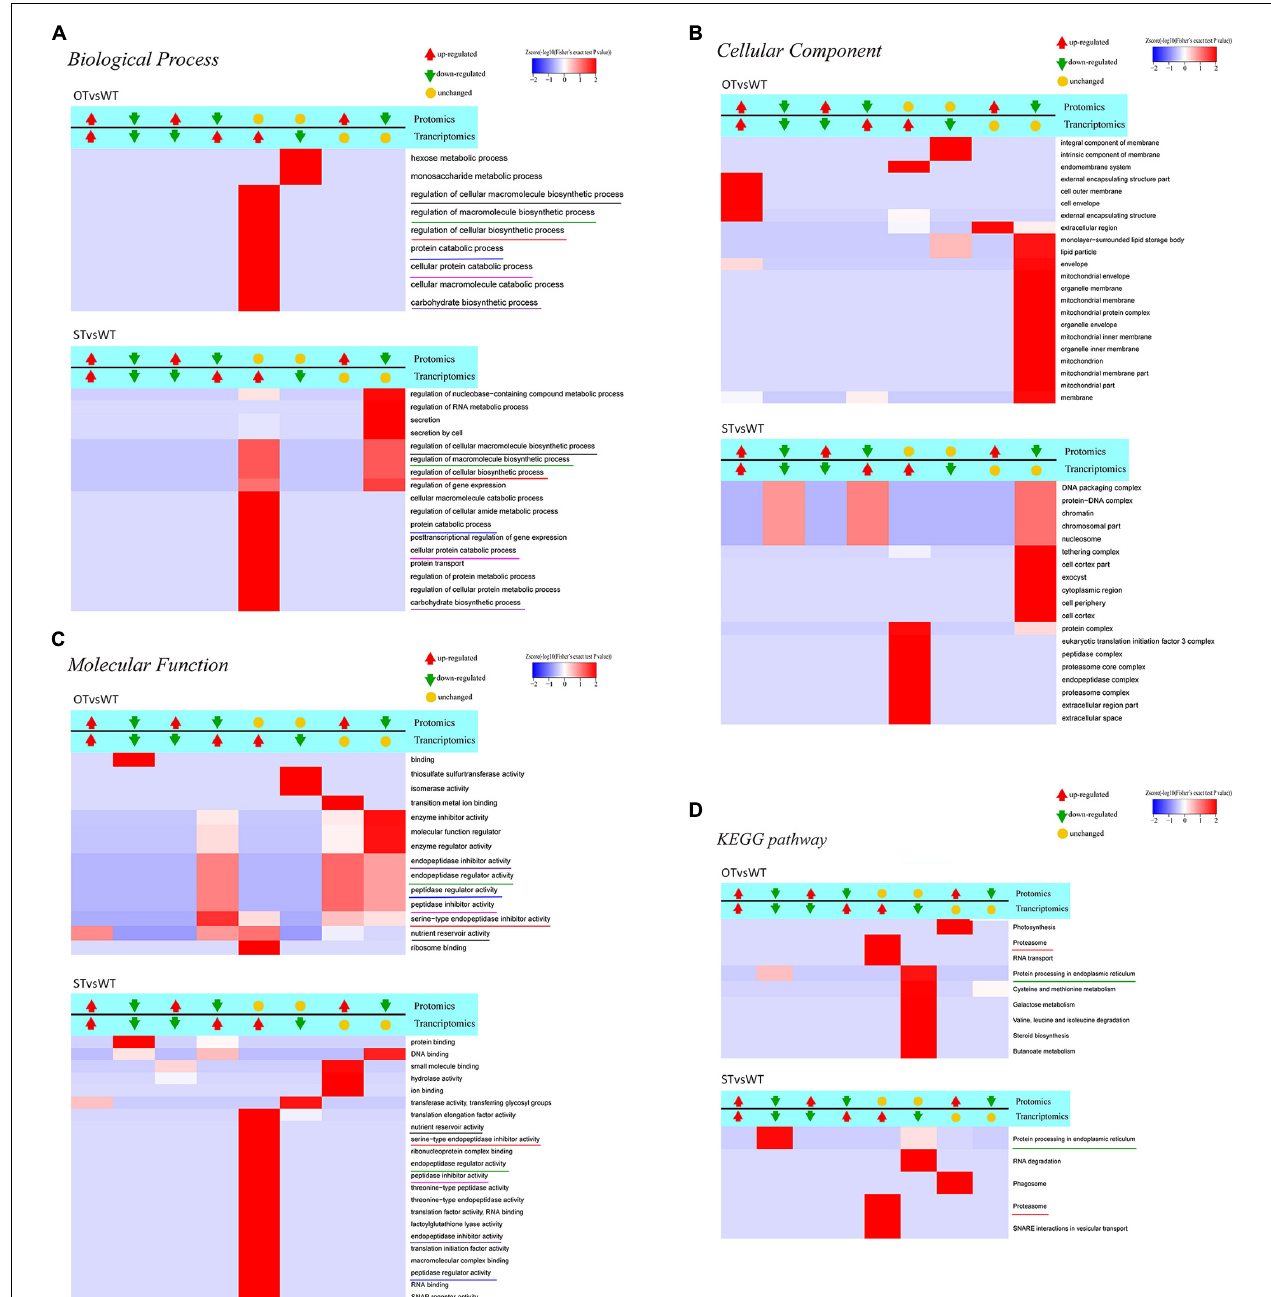
FIGURE 7 | Clustering analysis of the results of functional enrichment of DEGs/DEPs identified by transcriptome–proteome correlation analysis. The common GO terms and KEGG pathways in the STvsWT and OTvsWT groups are underlined by the same color. The darker the red color, the more significant the degree of enrichment. (A–C) The GO categories Biological Process, Cellular Component, and Molecular Function, respectively. (D) represents the KEGG pathway enrichment of